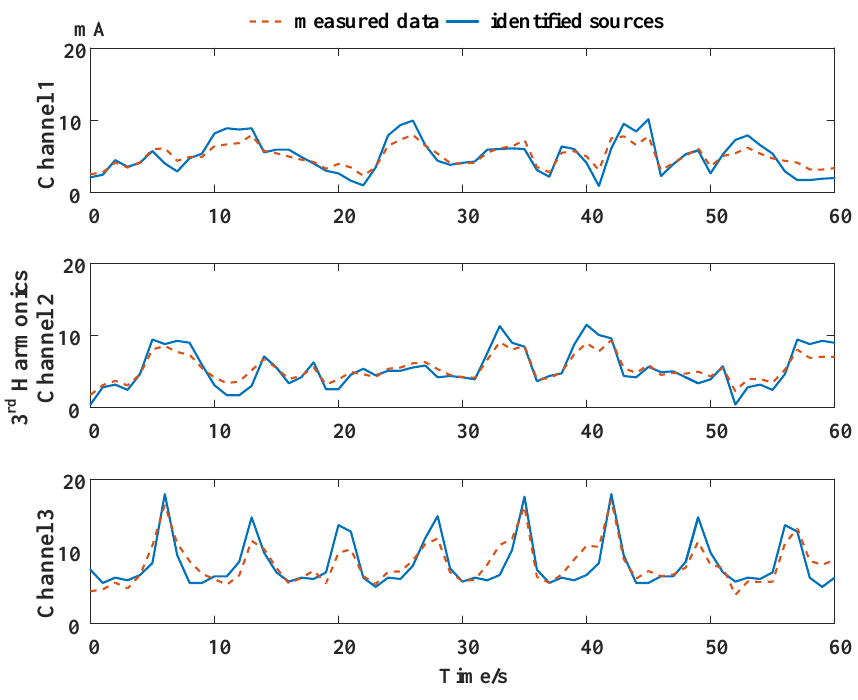
Figure 14. Third current harmonics of 3 typical channels at the same PCC with base frequency